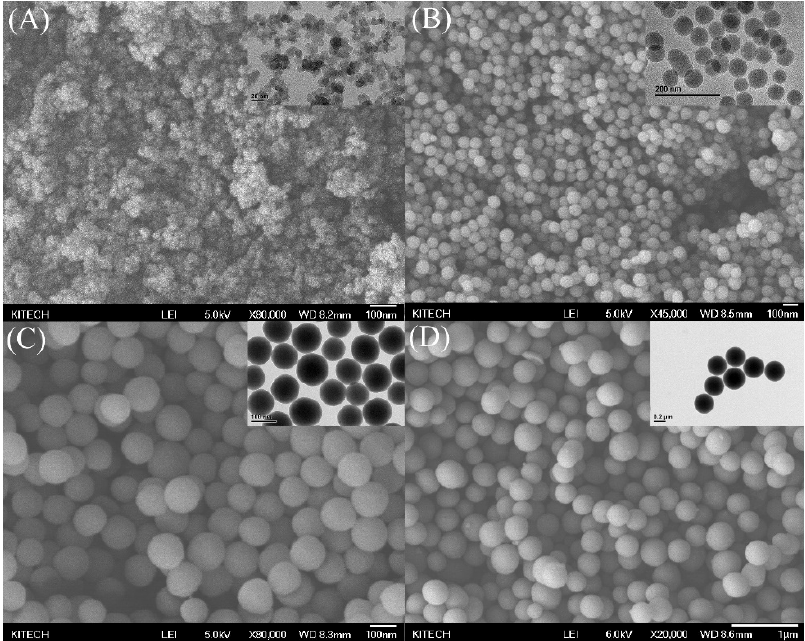
Figure 1. SEM images of ( A ) 12 nm-SiO 2 -SH, ( B ) 80 nm-SiO 2 -SH, ( C ) 150 nm-SiO 2 -SH, and ( D ) 350 nm-SiO 2 -SH (insets: corresponding TEM